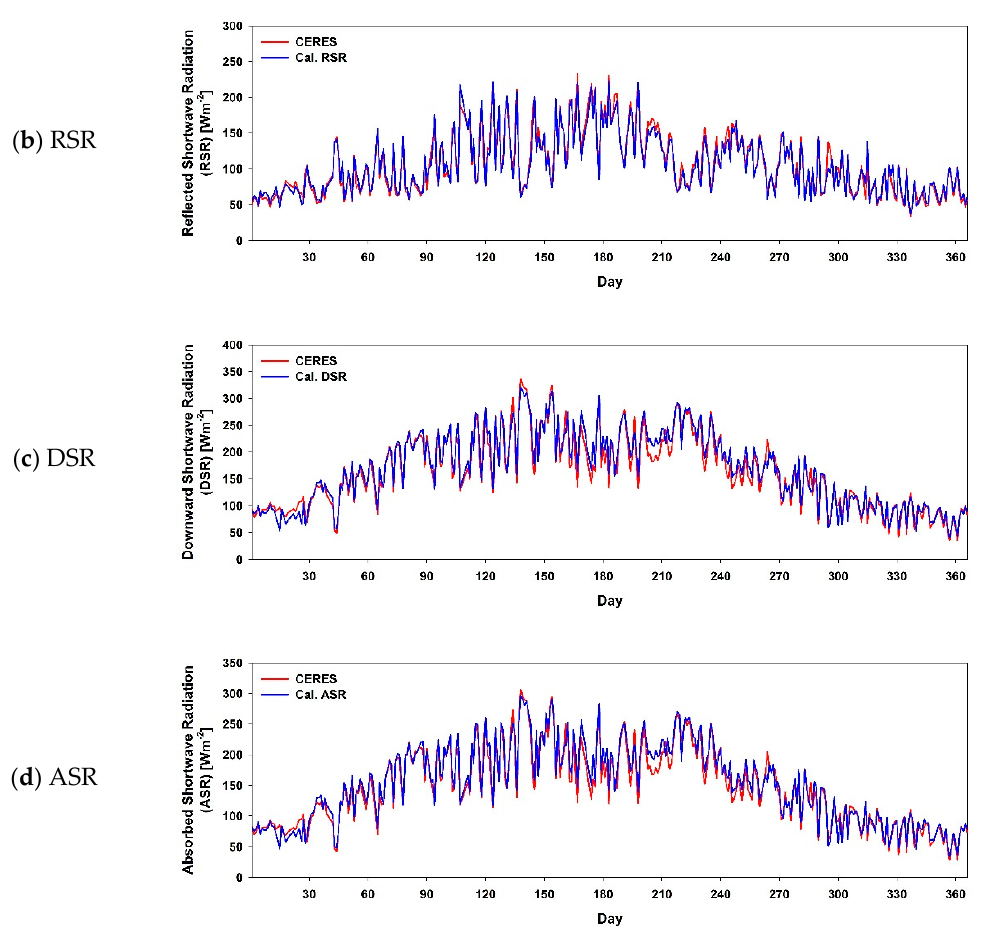
Figure 7. Daily mean time series distribution of CERES and calculated ( a ) ISR; ( b ) RSR; ( c ) DSR; and ( d ) ASR.